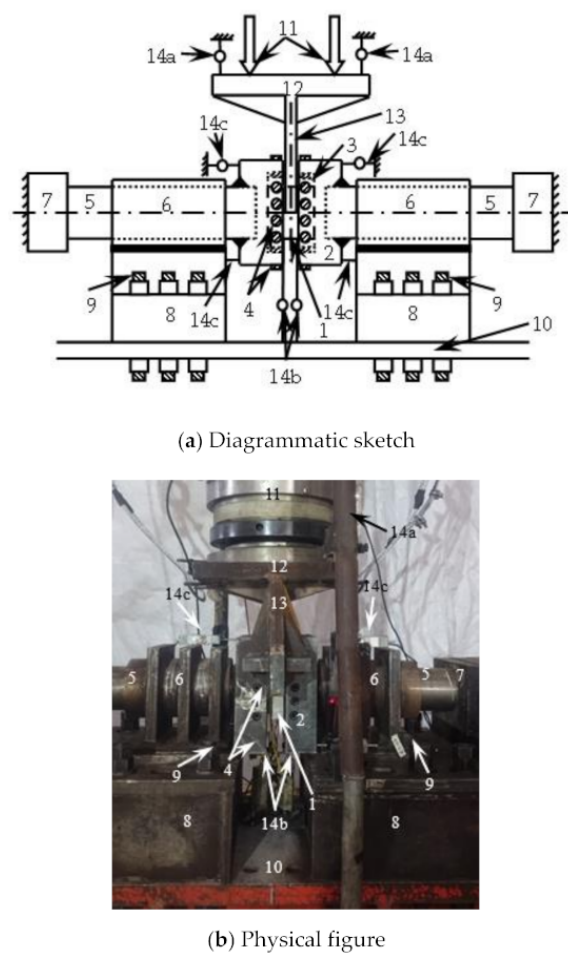
Figure 3. Loading setup. (1. Specimen, 2. embedded support, 3. rigid cushion block, 4. pressure bearing/positioning screw, 5. pressure bearing, 6. pressure bearing sleeve, 7. reaction pier, 8. rigid support, 9. high strength screw, 10. Self-reaction frame, 11. jack, 12. jack connecting plate, 13. rigid fixture, 14. displacement